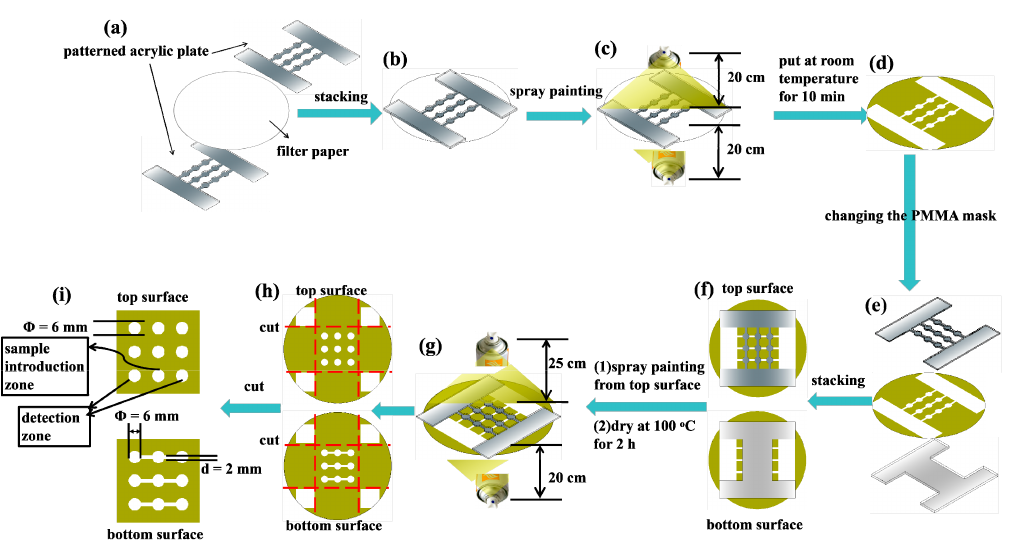
Figure 1. The diagram of the spraying prototyping technique for fabricating the three-dimensional single-layered paper-based microfluidic analytical devices (3D sl- μ PADs). ( a ) a sheet of filter paper and two PMMA boards with the same design. ( b ) the paper and two PMMA boards were stacked together. ( c ) the first spraying process. ( d ) the device was dried at room temperature for 10 min. ( e ) the filter paper and two PMMA boards with different designs. (f) the paper and two PMMA boards were stacked together. ( g ) the second spraying process. ( h ) the excess materials were trimmed. ( i ) the finished layout of the 3D sl- μ PADs.